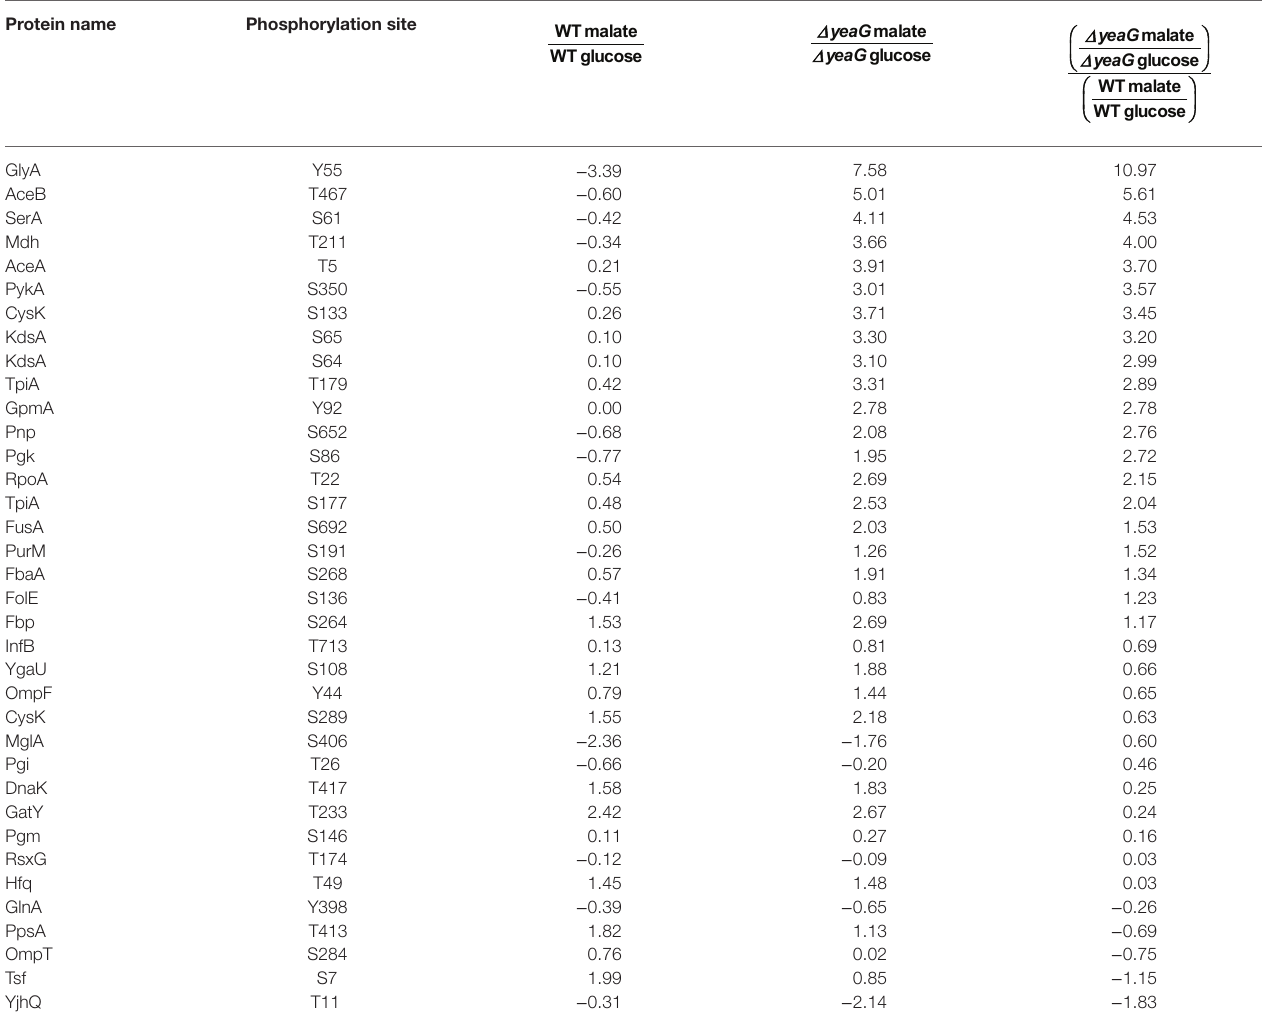
TABLE 2 | List of phosphorylation sites quantified in both strains in both